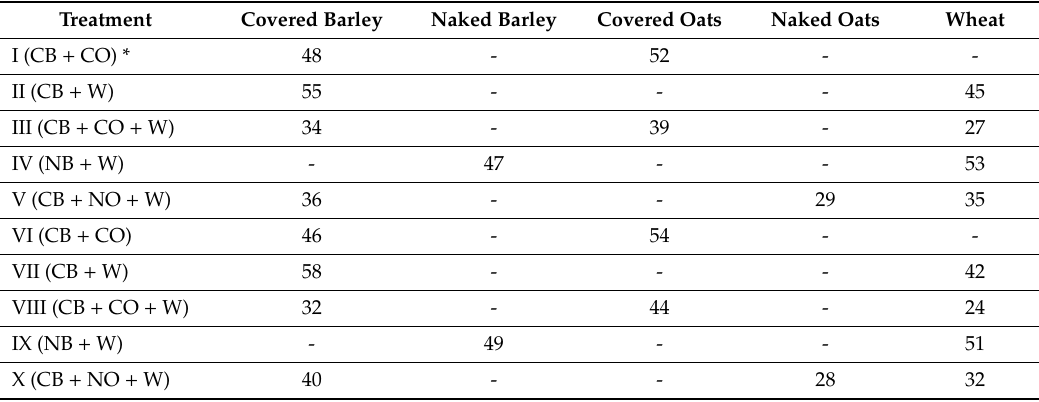
Table 5. Yield sharing (%) of each partner in mixture on Haplic Arenosols (average 2013–2015). Treatment Covered Barley Naked Barley Covered